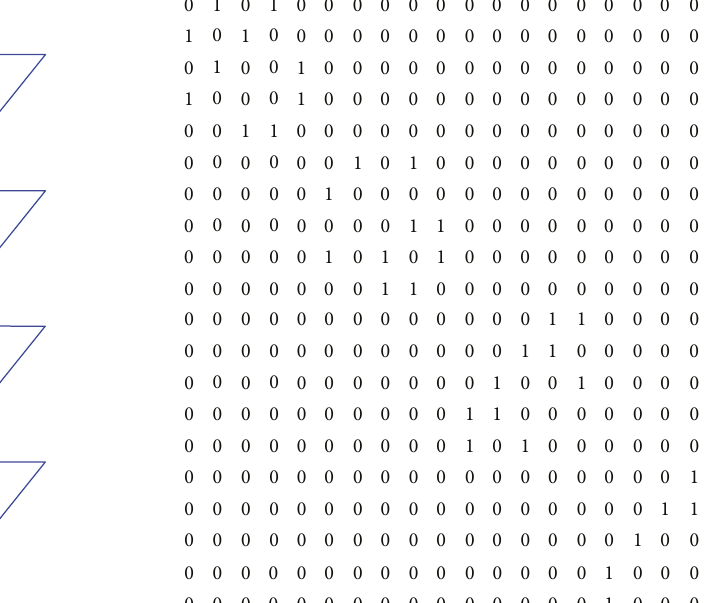
Figure 1: The multiplex network describing team social